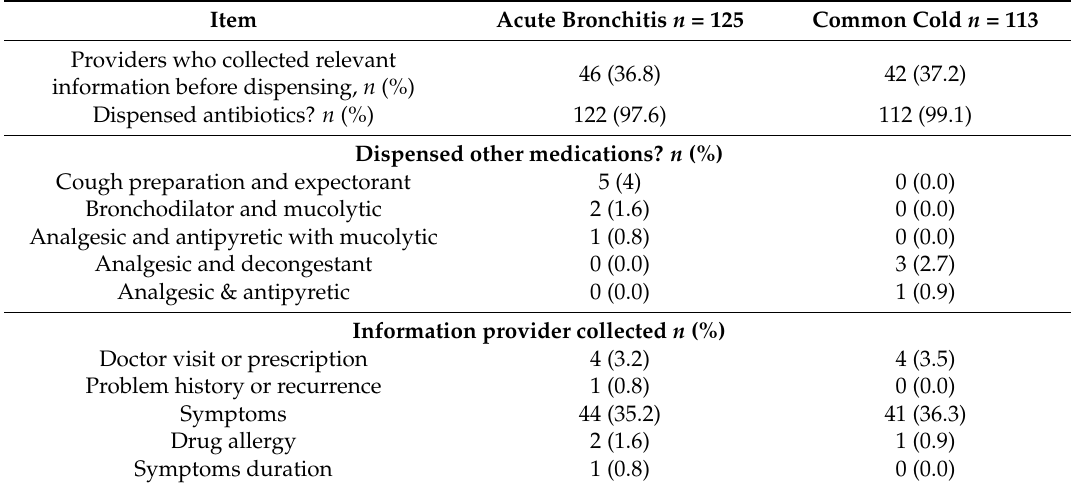
Table 2. Dispensing decisions and information gathered in simulated patient